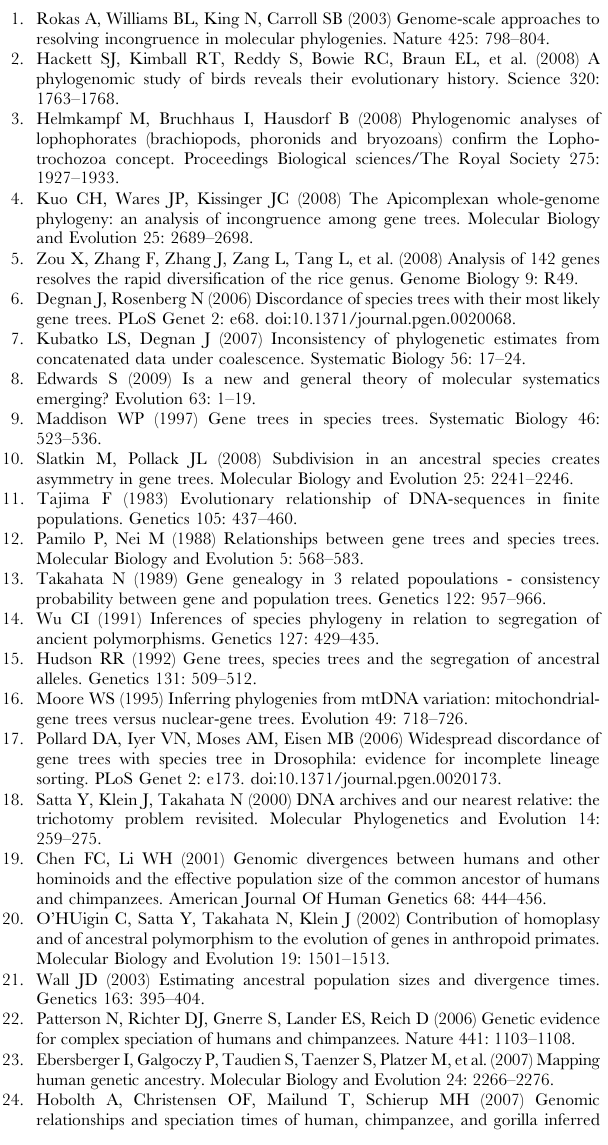
three starting intervals: 25, 50, or 100 SNPs. Colors correspond to the three topologies. Error bars are 95% credibility intervals. Figure S8 Phylogenetic discordance and long-branch attraction. The rat sequence was randomly shuffled to erase any phylogenetic signal between rat and house mice on chromosomes 18 and 19. Without the sequence shuffled (A), topologies significantly deviate from a 1/3, 1/3, 1/3 ratio. With the rat sequence shuffled (B), the topologies converge to a 1/3, 1/3, 1/3 ratio. This indicates the rat sequence provides a strong phylogenetic signal and the patterns of discordance are not driven by long-branch attraction. Colors correspond to the three topologies. Error bars are 95% credibility intervals. Table S1 Genomic locations and posterior probabilities of the 14,081 loci (computed with a prior probability of gene tree concordance set at a =